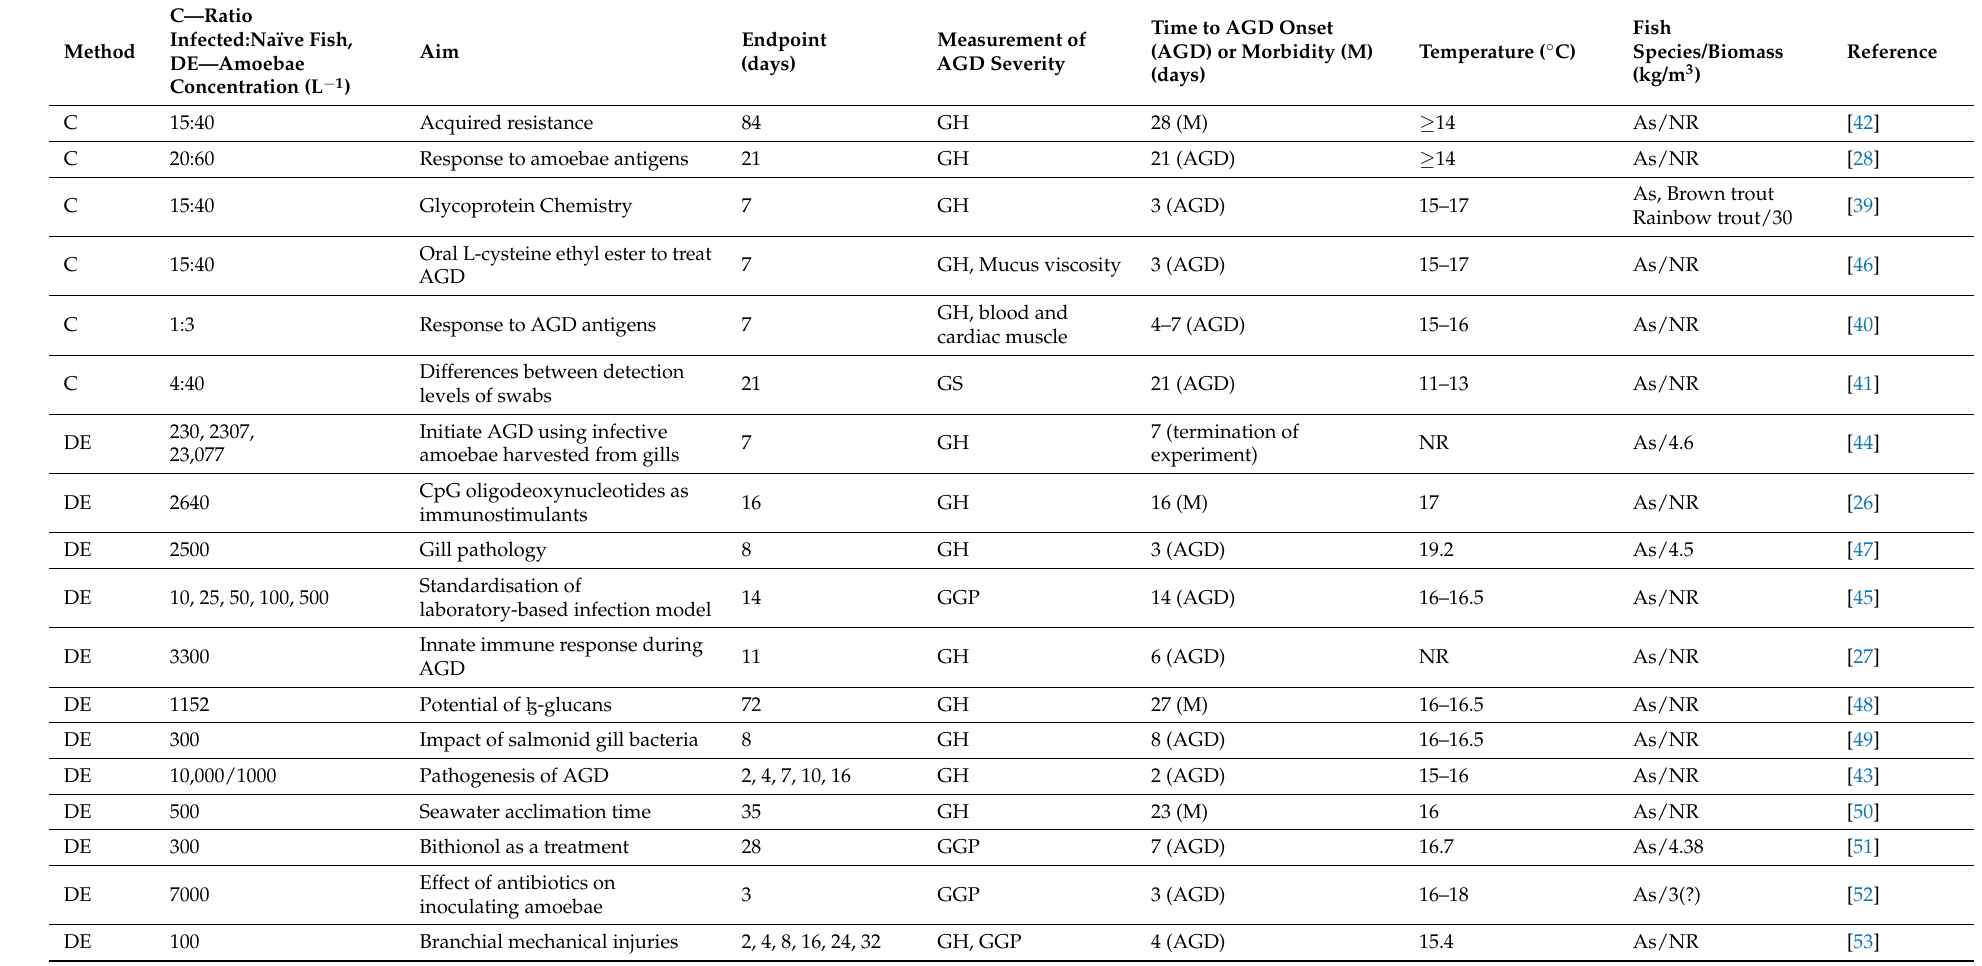
Table 1. Examples of different challenge methods used in AGD experiments. C—cohabitation, DE—direct exposure to amoebae, GH—gill histology, GS—gill swabs, GGP—gross gill pathology, As—Atlantic salmon, NR—not